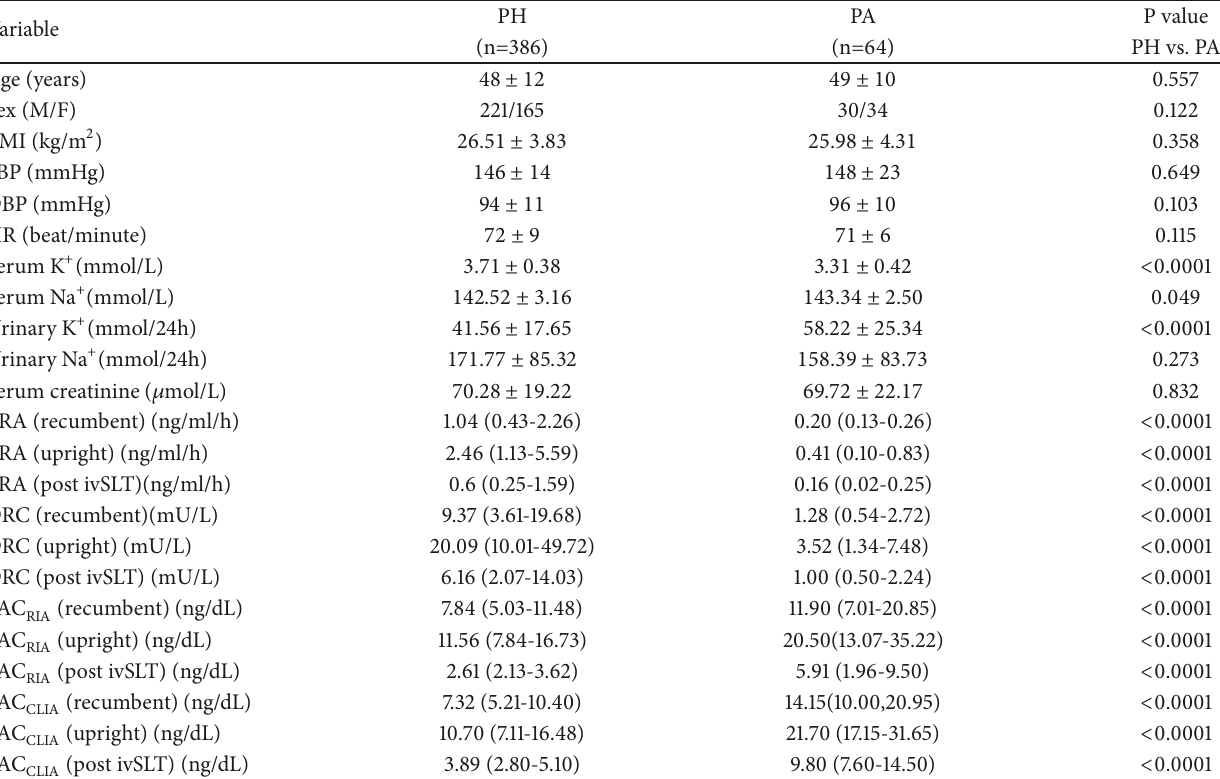
Table 3: Anthropometric and clinical characteristics of the hypertensive patients screened in our study.